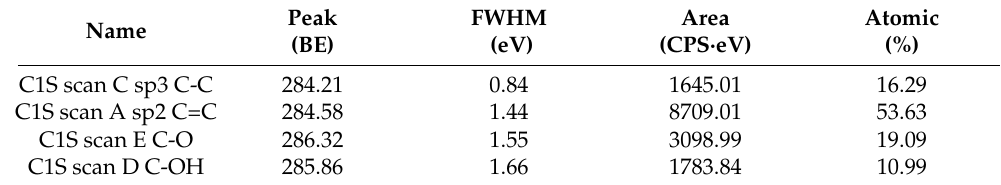
Table 3. Elements identifier and quantitative assessment of shungite samples after